Question: What kind of plot is shown here?
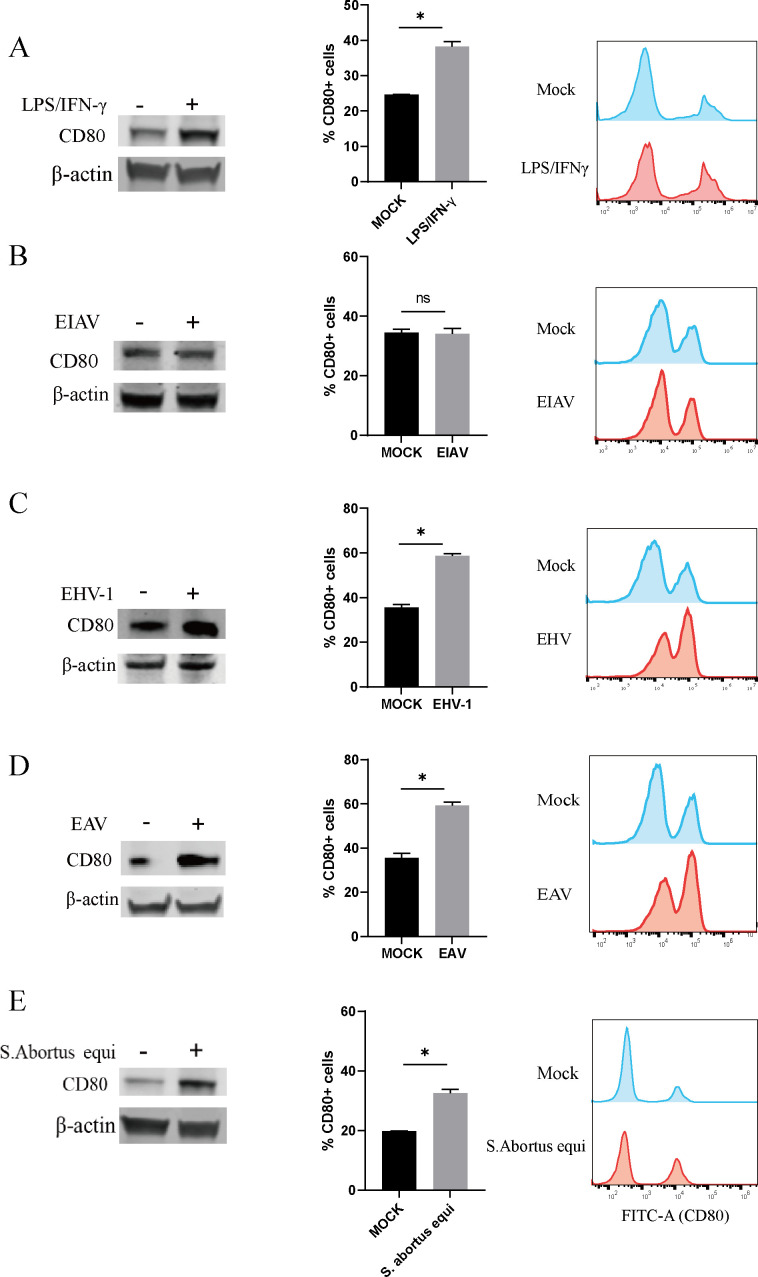
Answer: histogram